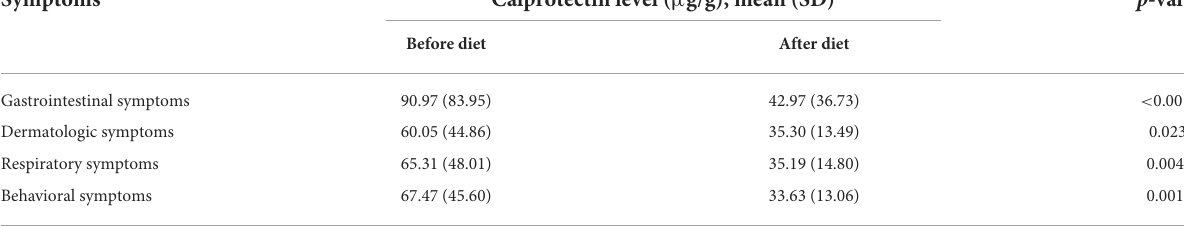
TABLE 3 Calprotectin levels and symptoms of children following the elimination diet ( n =